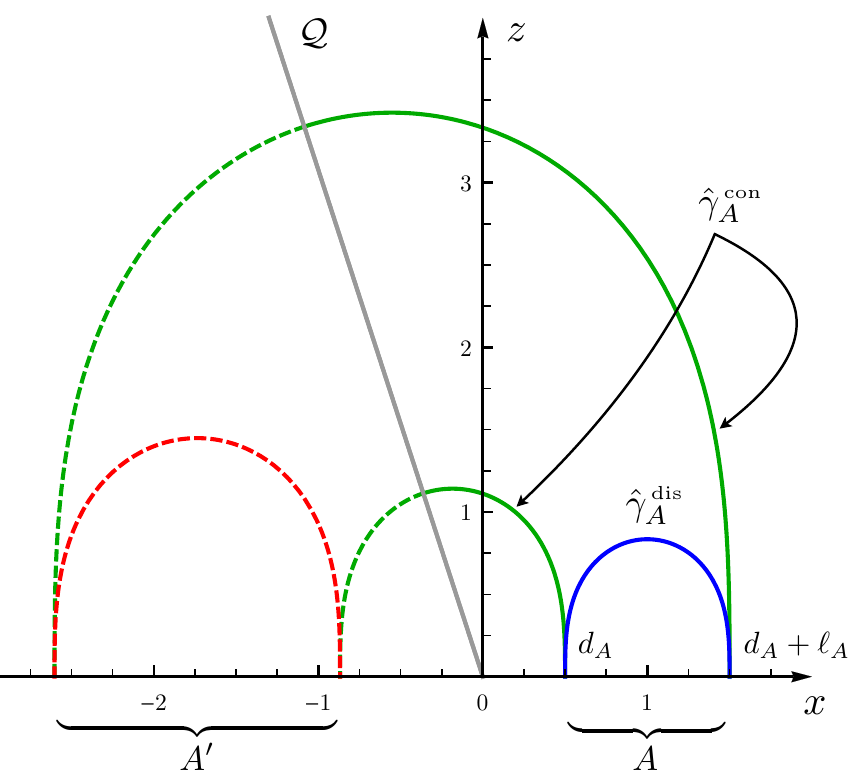
Figure 11 . In(cid:12)nite strip of width ‘ A parallel to the boundary at distance d A : section of the surfaces ^ (cid:13) dis and ^ (cid:13) con (blue and green solid curve respectively) which are local extrema of the area A A functional. In this plot (cid:11) > (cid:11) c . The auxiliary domain A in(cid:12)nite strips A and A 0 . The green dashed curves together with ^ (cid:13) con while the red dashed curve together with ^ (cid:13) dis where a ( (cid:11) ) has been introduced in (5.9) and h 0